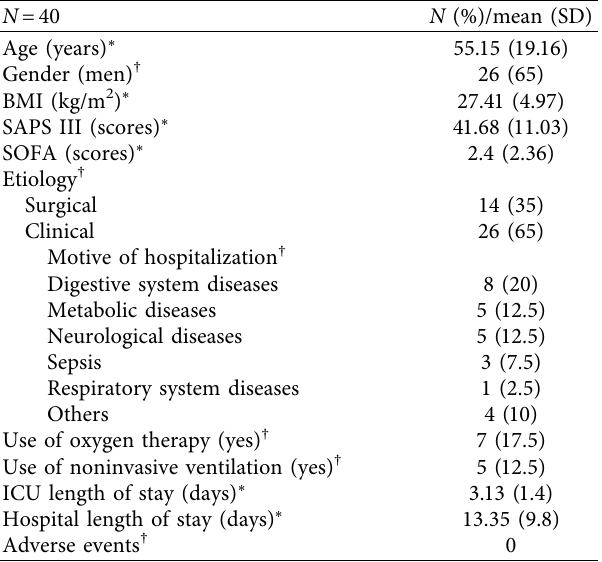
BMI: body mass index. SAPS III: Simplified Acute Physiology Score III. SOFA: Sequential Organ Failure Assessment. ∗ Variables expressed in mean (standard deviation). † Variables expressed in absolute frequency